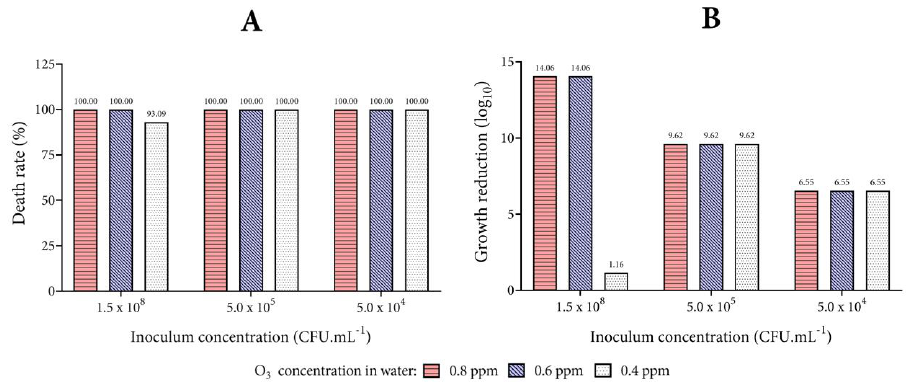
Figure 7. Action of ozonized water on yeast C. albicans . Analysis of the percentage of death ( A ) and growth reduction in Log 10 ( B ) for C. albicans . The concentrations of 0.8, 0.6, and 0.4 ppm of O 3 dissolved in tap water were tested, and the number of colonies on each agar plate was calculated after incubation (1.0 mL of inoculum and 4.0 mL of ozonized water at 20 °C for 1 min).